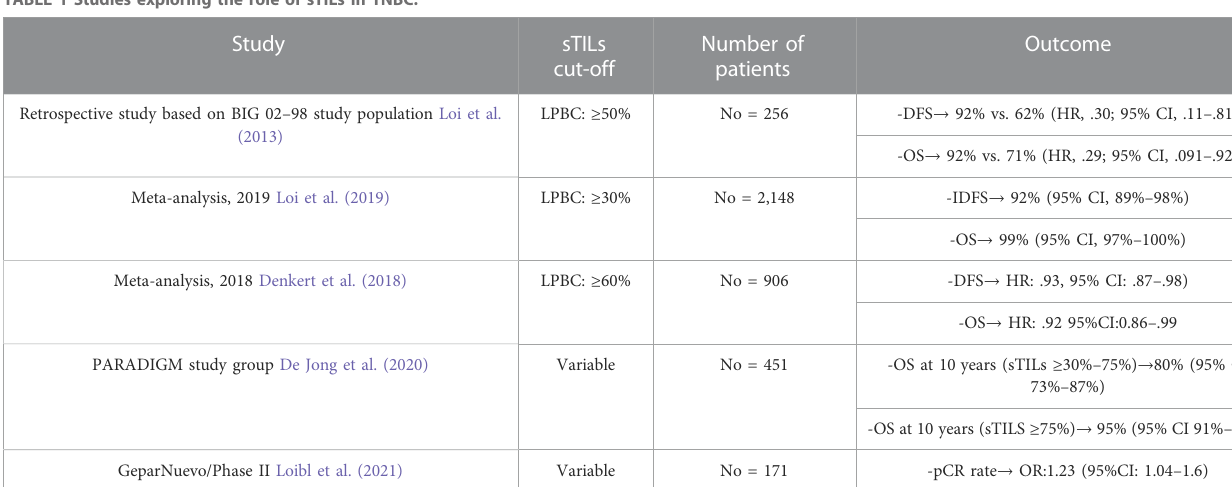
TABLE 1 Studies exploring the role of sTILs in